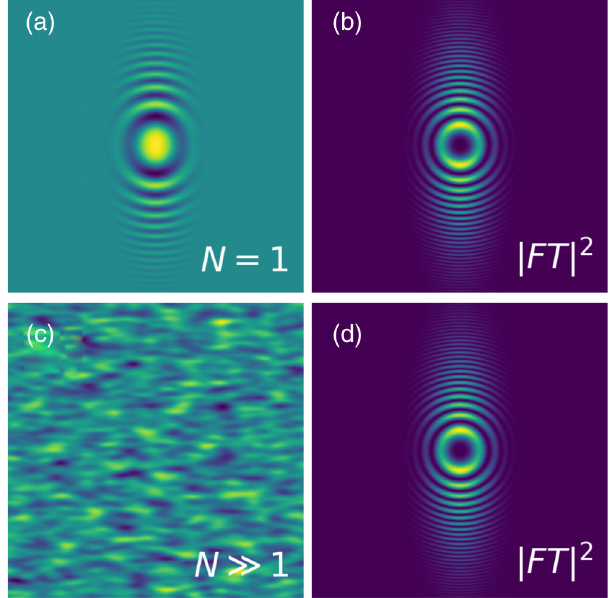
FIG. 3. Simulated single-scatterer interference pattern (a) and corresponding 2D power spectrum (b) for a horizontally elon- gated electron beam. Simulated heterodyne speckles (c) and corresponding 2D power spectrum (d) for the same electron beam configuration as in (a) and (b). Notice that the power spectrum of heterodyne speckles closely resembles the power spectrum of the single-scatterer